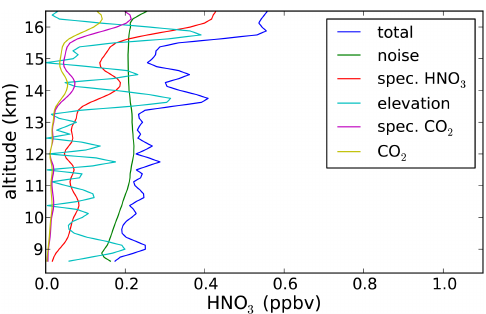
Figure 10. Error budget for HNO 3 for GLORIA Image 72.